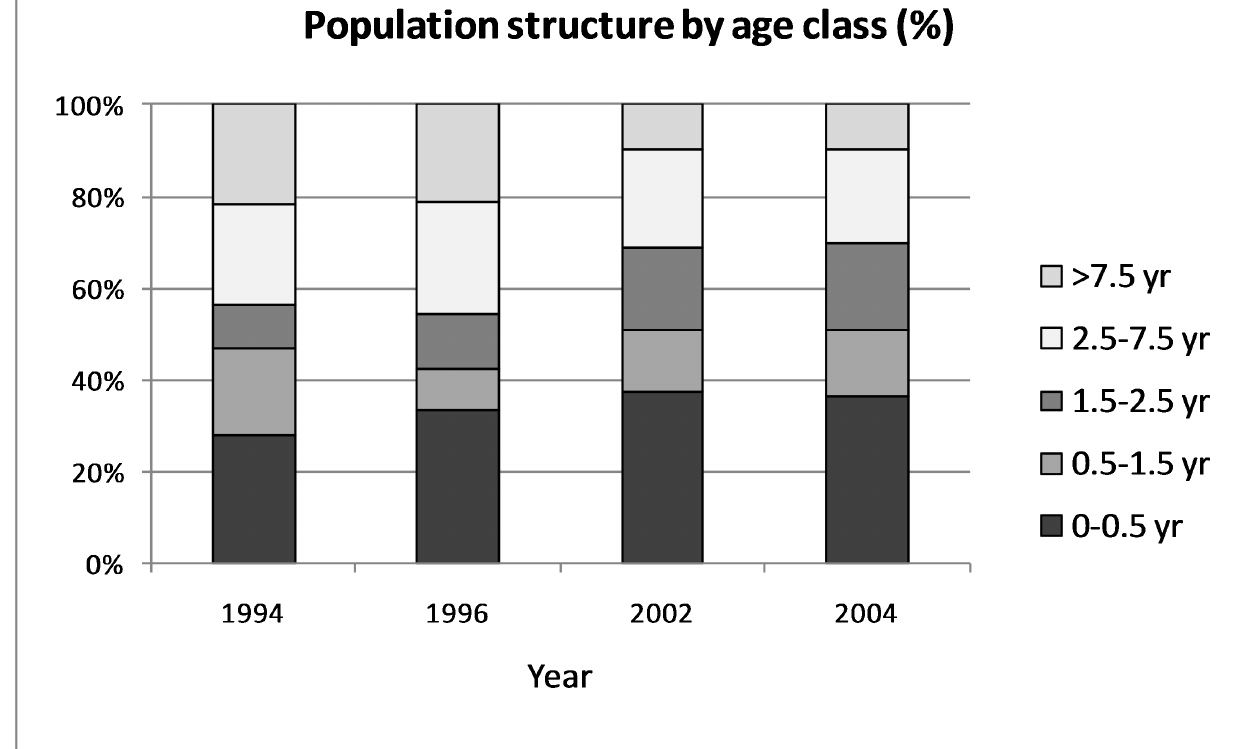
Figure 4. Population structure by age class, years 1994, 1996, 2002 and 2004.